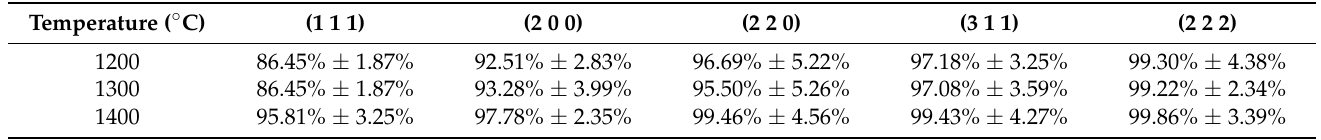
Table 1. Crystallinity of TaC nanoparticles at carbonization temperatures from 1200 ◦ C to 1400 ◦